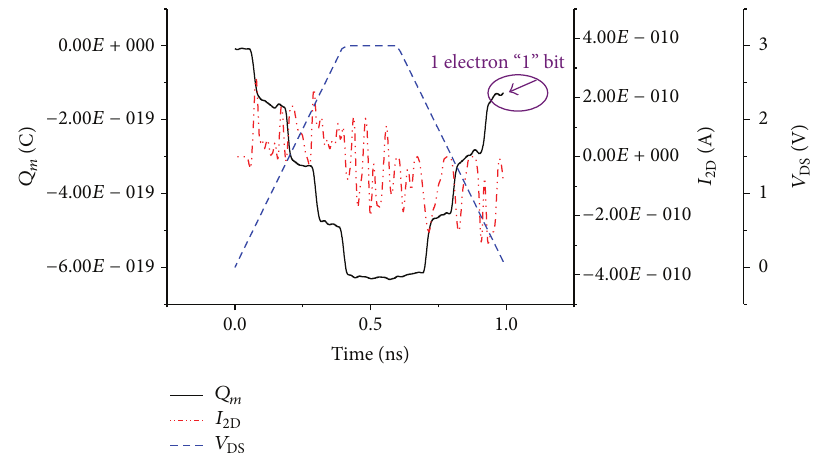
Figure 9: Simulation of the logical “1” at 300 K. The applied write voltages induce a 2D-MTJs oscillations current for traped electron.